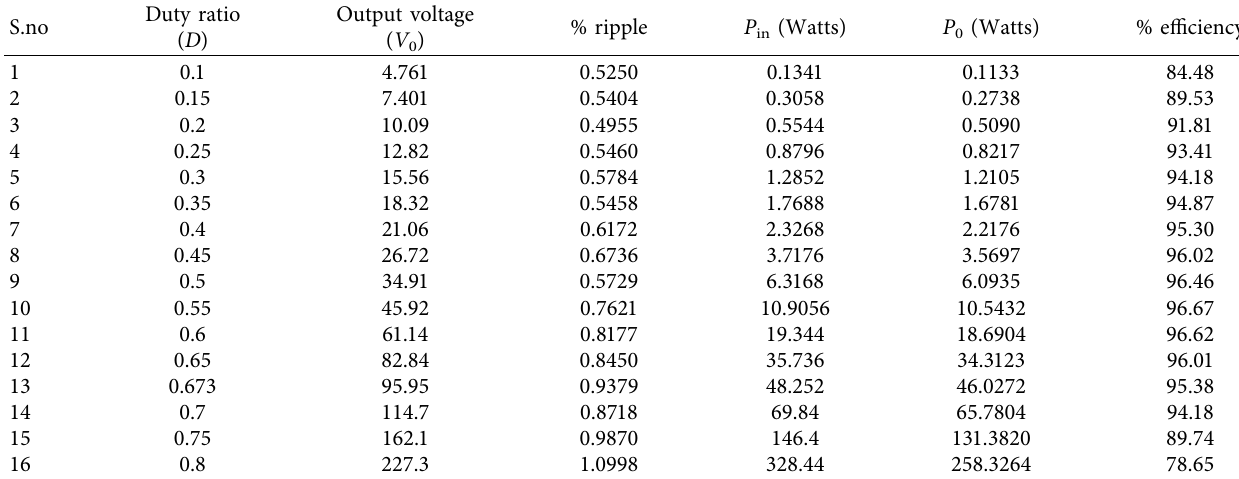
Table 3: Performance analysis for various duty ratios.